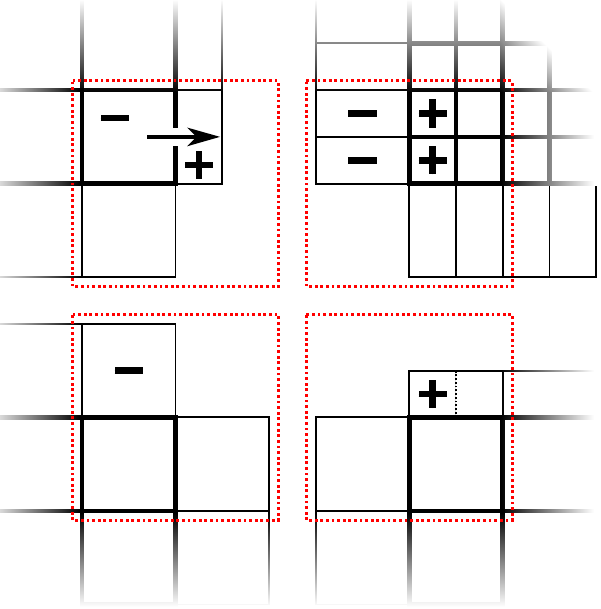
Fig. 4. Multiple representation of the same physical region (marked by red rectangles) and source/sink terms caused by a specific advec- tive flux. Fig. 3. Exchanges in course of a macro time step for method based on RK2a, see also Table 1. The c O and c I denote the nodes of the i i inner and outer base method.